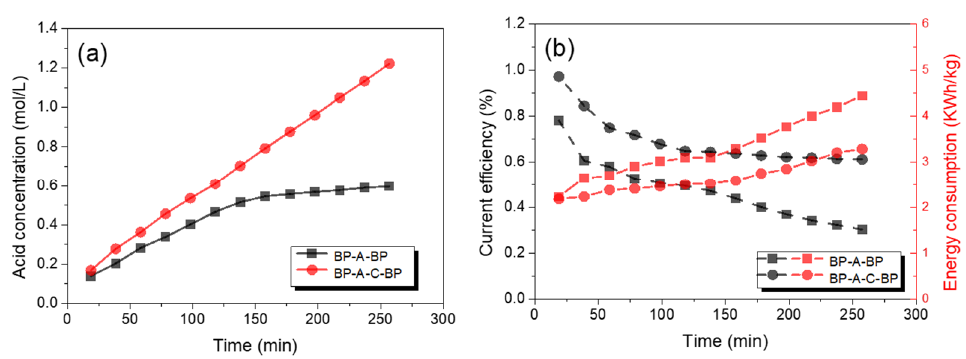
Figure 10. The concentration of sulfuric acid ( a ), current efficiency, and energy consumption ( b ) in different configurations.